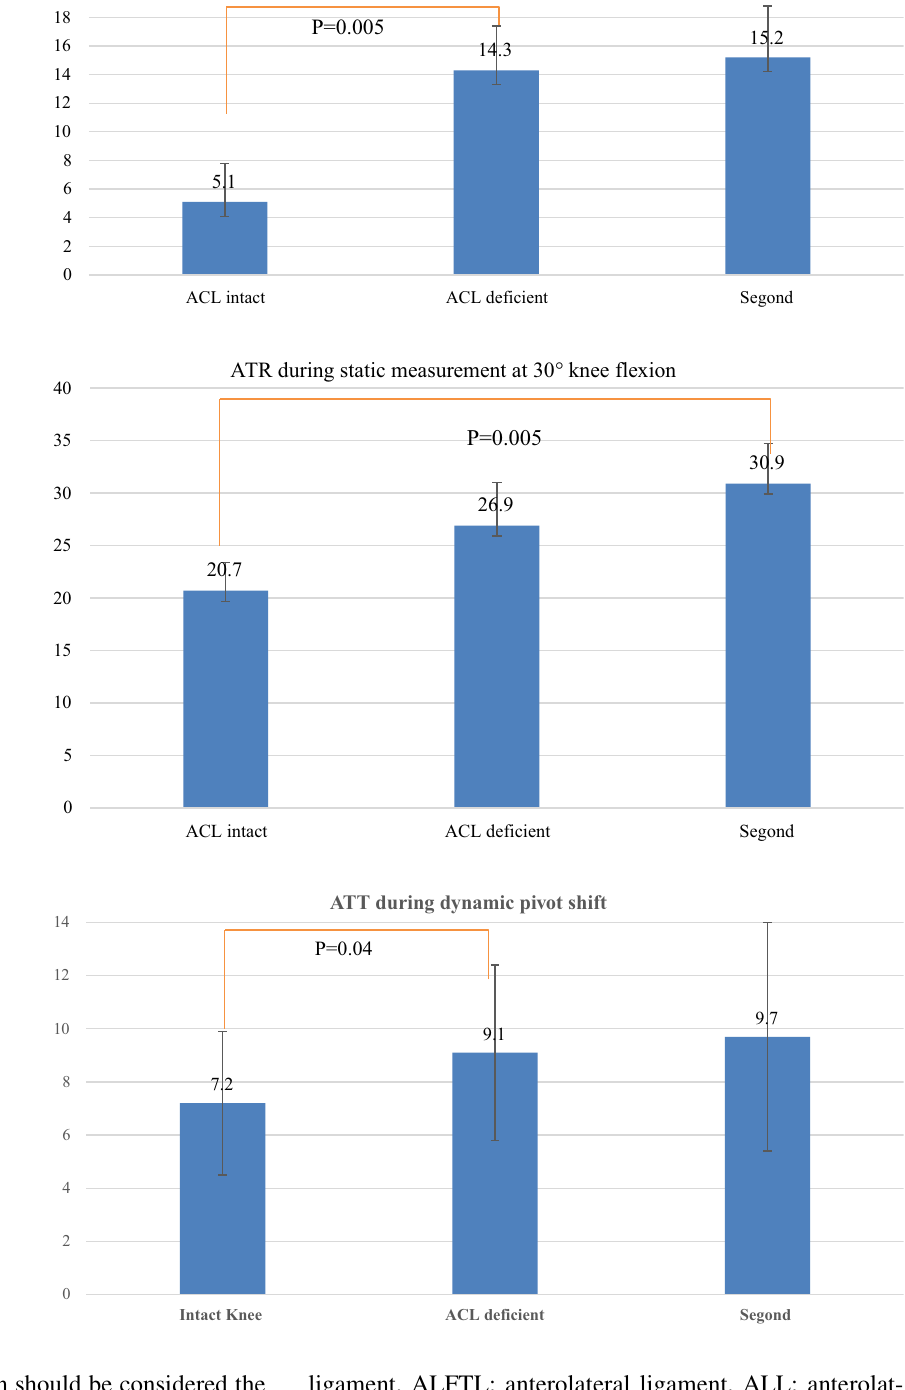
Fig. 2 Anterior tibial translation during pivot-shift (static measurements)